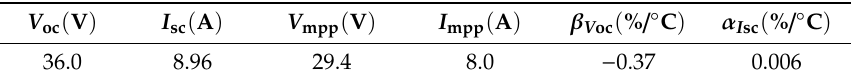
Table 2. PV module parameter data